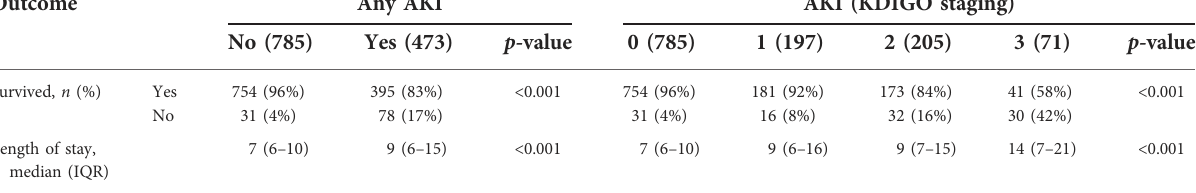
TABLE 3 Duration of stay and clinical outcomes by AKI